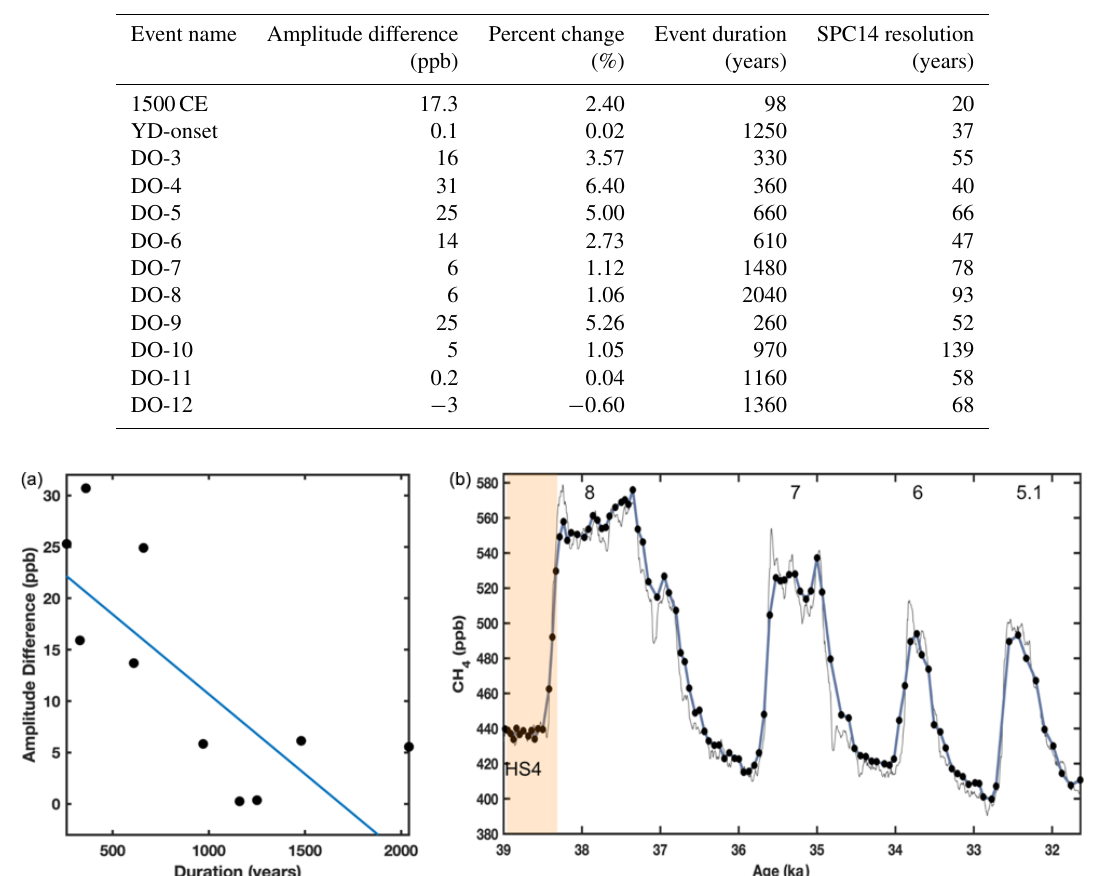
Table 2. Quantification of smoothing of the methane record in SPC14. Table shows comparison of event duration to the amplitude difference of events in the SPC14 and WD core (see Fig. 5). Spacing (in years) of SPC14 samples over the duration of the event.